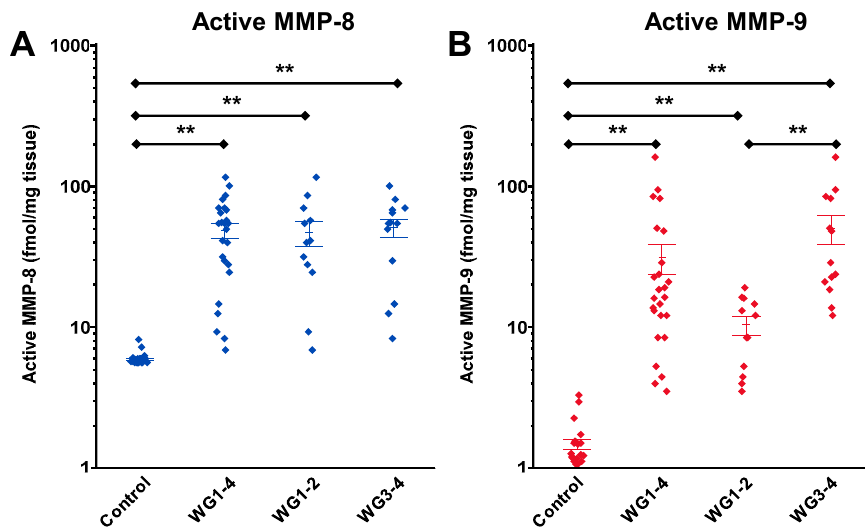
Figure 8. Validation of the target MMP-9 in debridement tissue from human patients with diabetic foot ulcers (DFUs). Measurements of ( A ) active MMP-8 and ( B ) active MMP-9 in human DFUs stratified by the Wagner grade (WG) using the batimastat affinity resin coupled with proteomics; mean ± SEM: * p < 0.05, ** p < 0.01 by Mann − Whitney U two-tailed test. Adapted from Nguyen at al. [48].